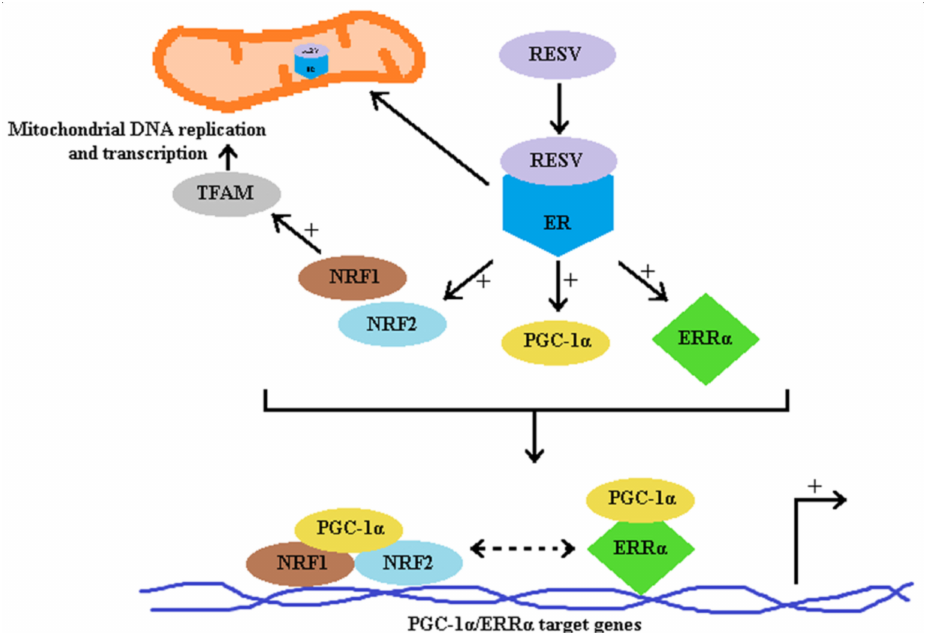
Figure 5. Proposed signaling pathway for the effect of resveratrol involving ER (estrogen receptor). Resveratrol (RESV), estrogen related receptor alpha (ERR α ), PPAR gamma co-activator 1 alpha (PGC- 1 α ), nuclear respiratory factors 1 and 2 (NRF1, NRF2), mitochondrial transcription factor A